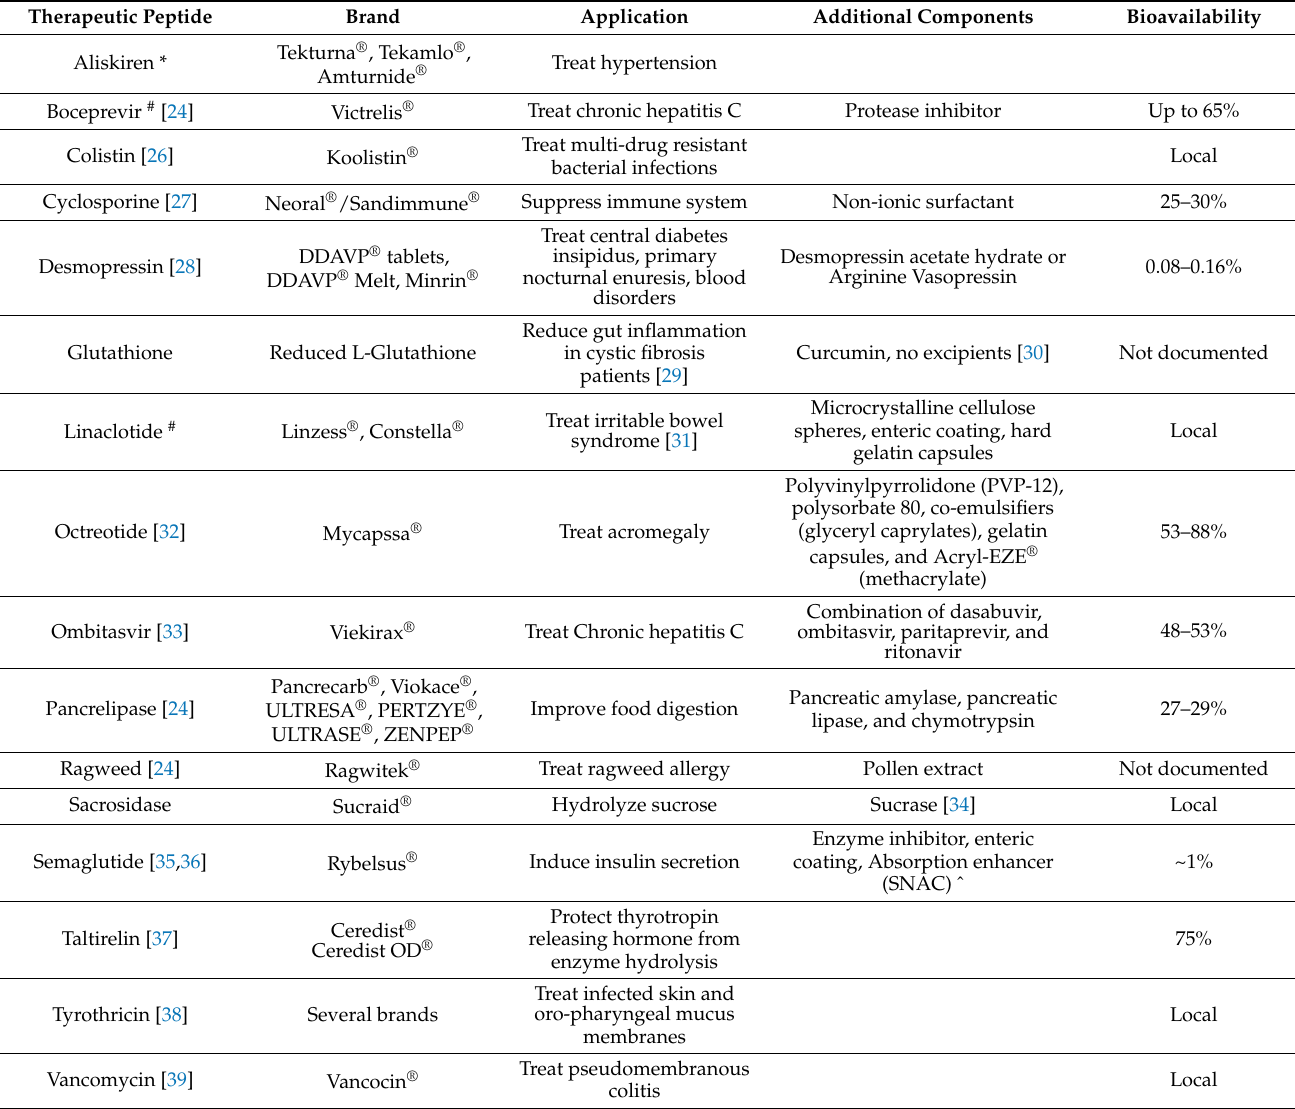
Table 1. Commercially available FDA-approved oral peptide formulations [24,25] (* discontinued after 2017, # also approved by EMA). ˆ Sodium N-[8-(2-hydroxybenzoyl) amino